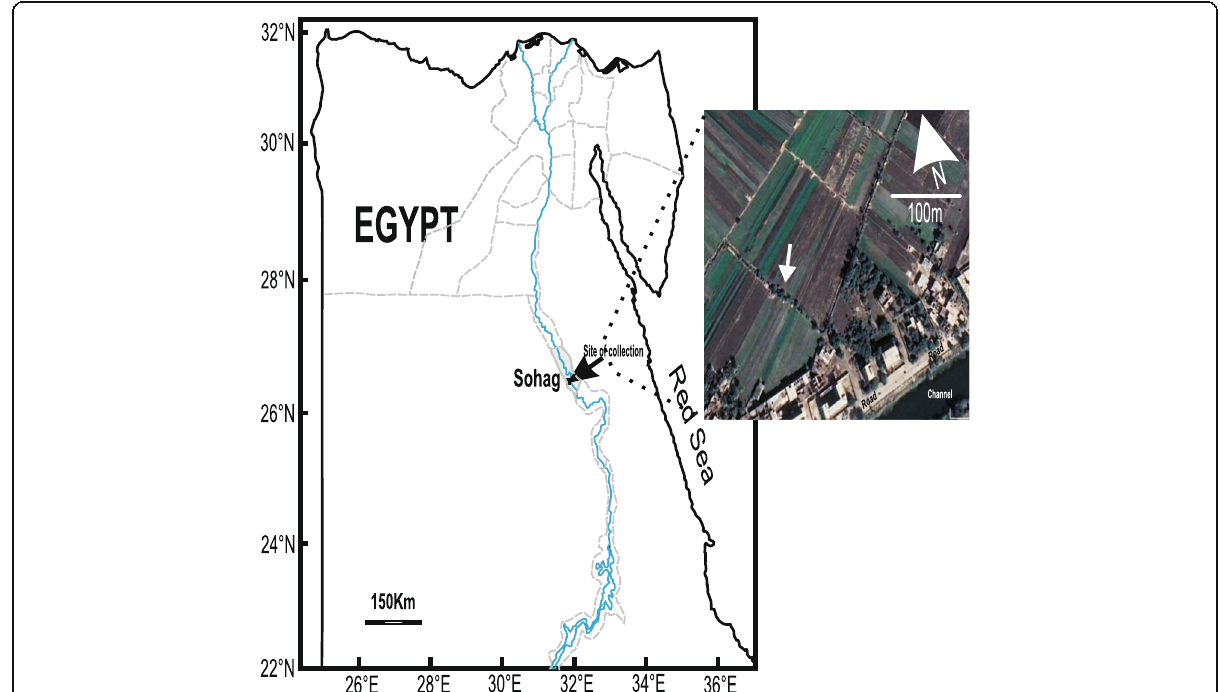
Fig. 1 Map of Egypt showing the location of Sohag Governorate and site of collection. To the right a Google earth map showing the agricultural field and willow trees (arrow), where the specimens were